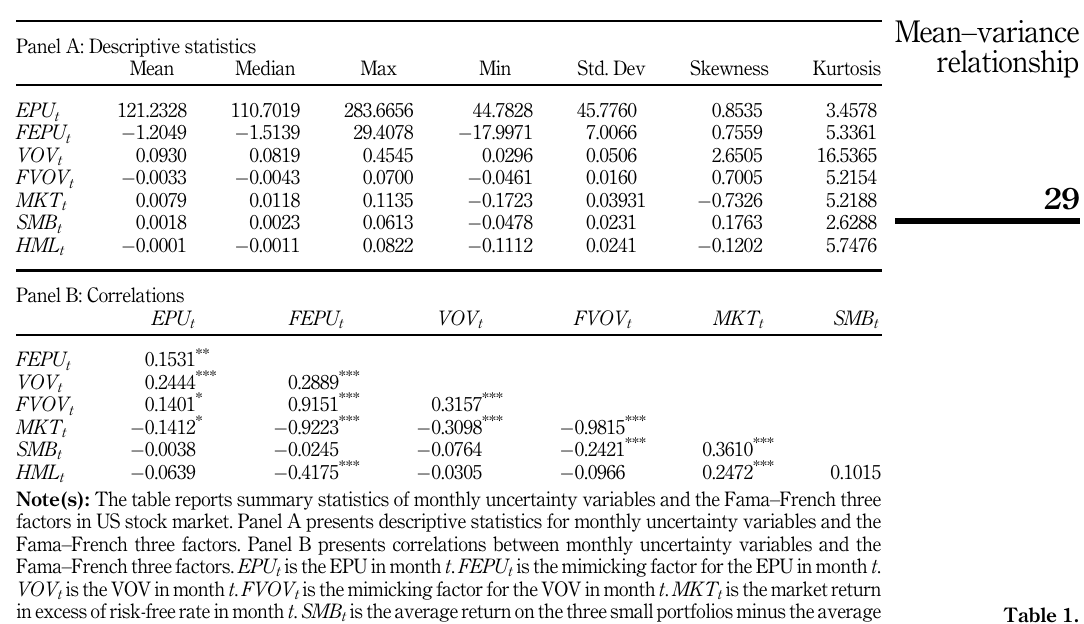
Table 1. Summary statistics